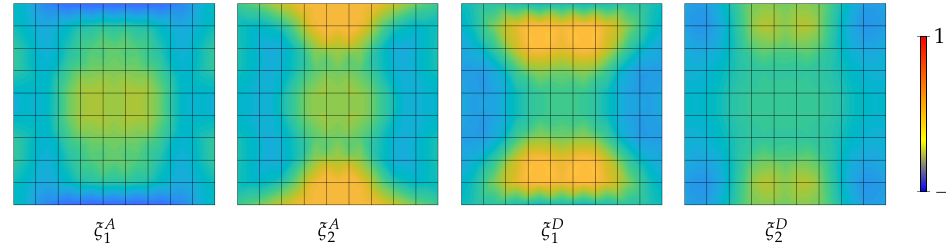
Figure 6. Optimal distribution of lamination parameters over the shell domain for the material grid of 9 9 elements [35]. ×